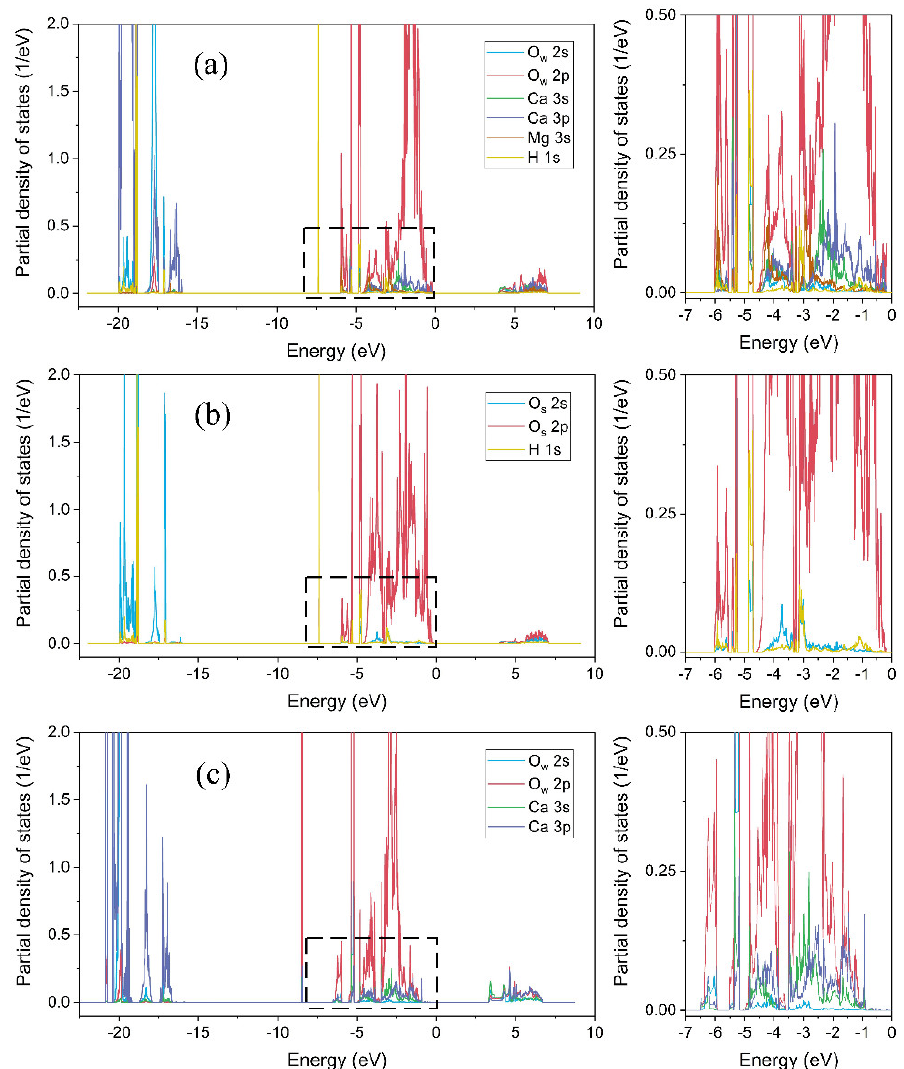
Figure 3. Partial density of states (PDOS) of the water adsorption on the Mg-doped β-C 2 S (100) and (011) surfaces: ( a ) dissociative adsorption on the Mg-doped β-C 2 S (100) surface-O w bonding, ( b ) dissociative adsorption on the Mg-doped β-C 2 S (100) surface-H d bonding, and ( c ) molecular adsorption on Mg-doped β-C 2 S (011) surface. Note: right sub-figures are enlarged representations of regions in the box and the Fermi energy was set at 0.00 eV.